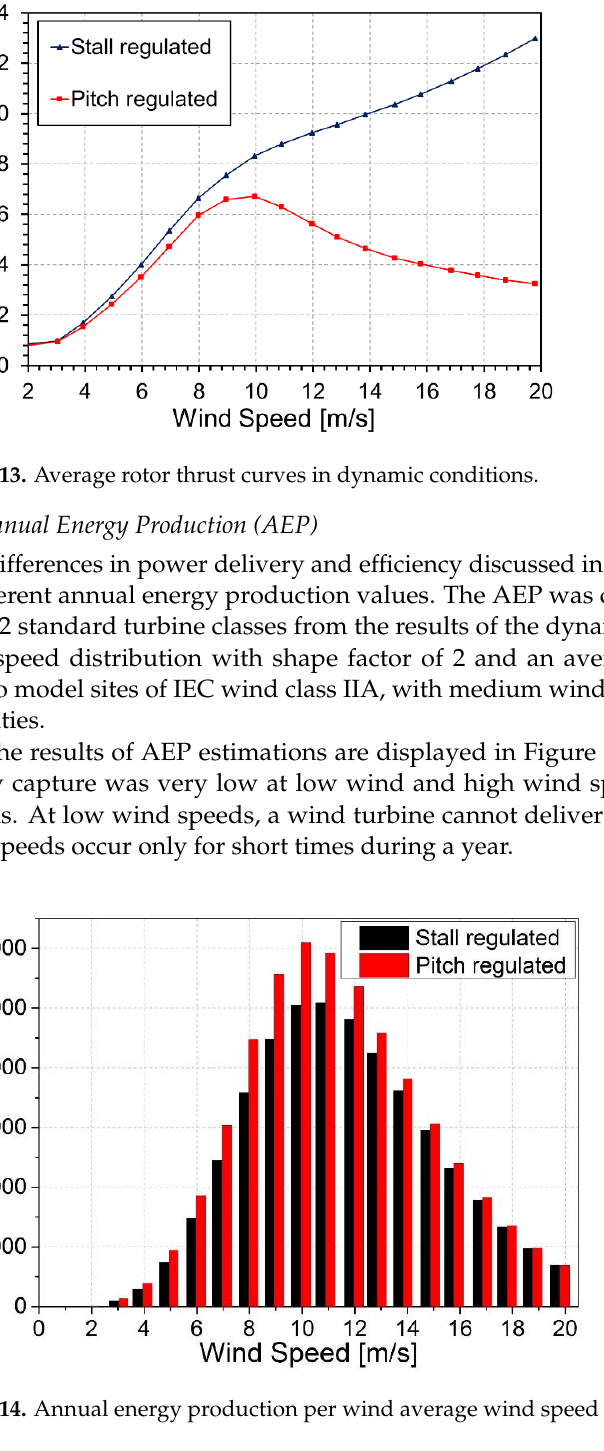
( b ) Figure 12. Power curves for the pitch- and stall-regulated turbines in steady conditions ( a ) and dynamic inflow conditions ( b ). In above-rated flow speed operation, the stall-regulated turbine was able to self-regu- late power output, as previously shown in Figure 7a. Unfortunately, as shown in Figure 13,